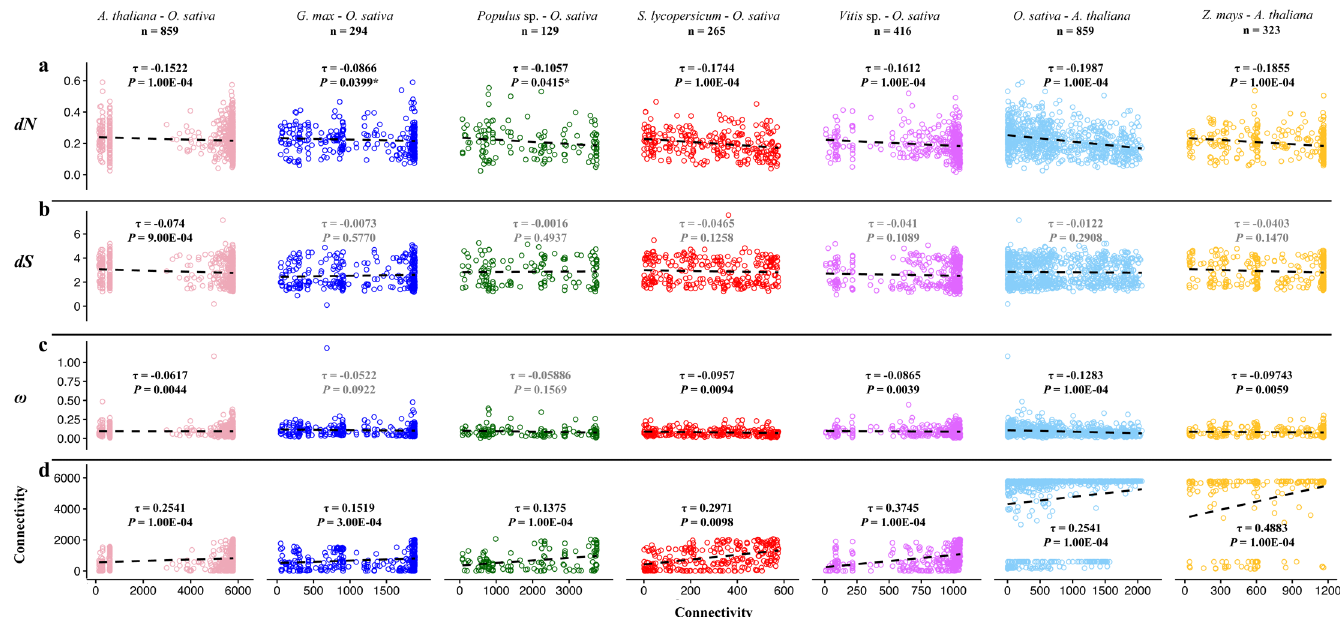
Fig 2. Linear regression of gene connectivity of seven taxa analyzed. Taxa: A . thaliana , G . max , Populusspp ., S . lycopersicum , Vitis spp ., O . sativa , and Z . mays , against(a): non-synonymous substitutions( dN ), (b): synonymoussubstitutions( dS ), (c): estimates of adaptive evolution( ω = dN / dS )and (d): number of connections in ortholog comparison. Circles represent genes, while the regressioncoefficient, represented as Kendall’stau ( τ ) coefficient, is the dashed line. Significance is indicatedby bold text. Note that all significantresults except the two marked with an asterisk ( * ) remainedsignificantafter correcting for multiplecomparisons (see text for